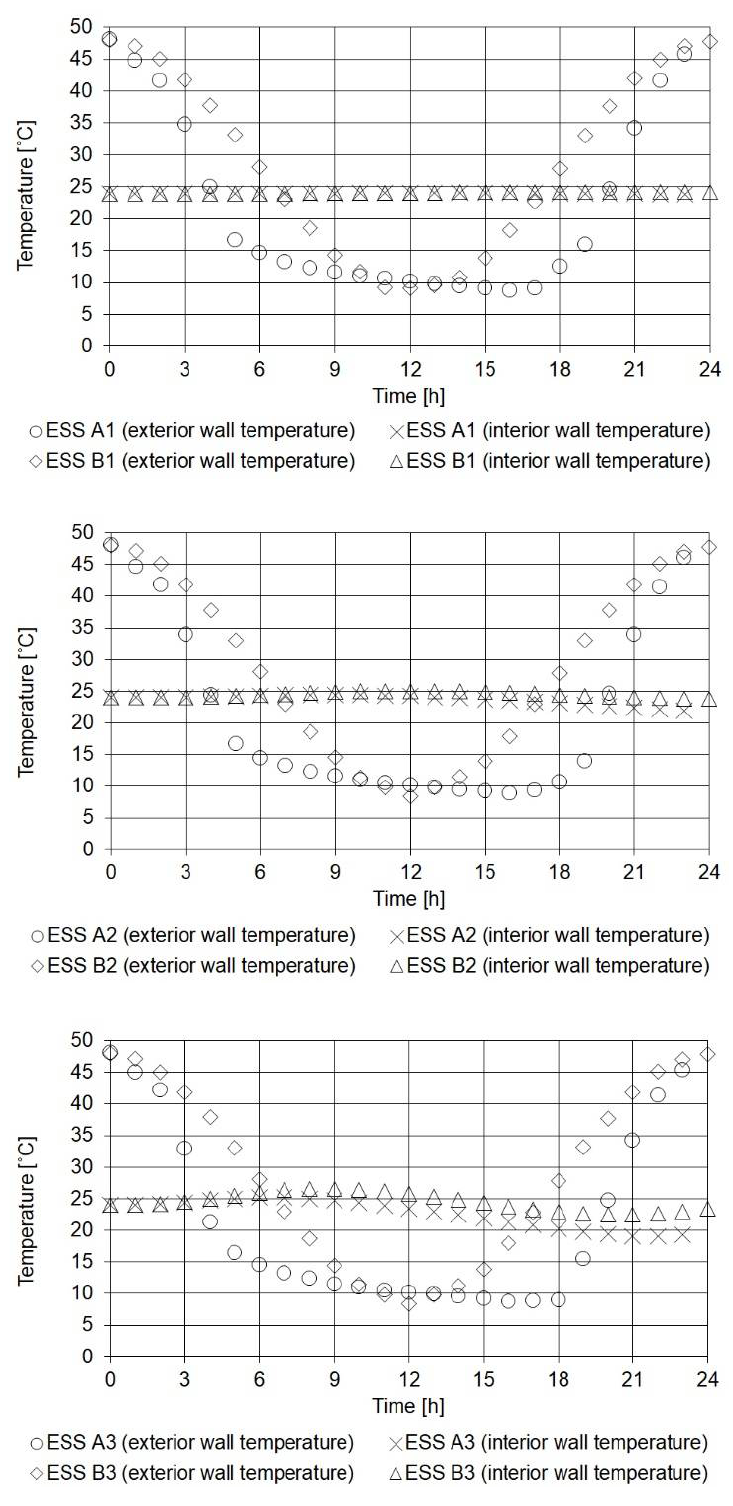
Figure 2. Simulation results for building wall models A and B for sunny spring conditions (ESS).